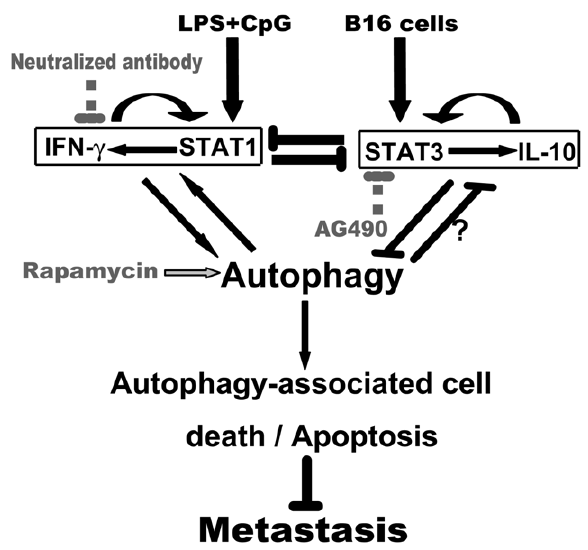
Figure 7. Mechanisms account for the different efficacies of prophylactic or therapeutic TLR4/9 agonist complex against metastasis. Prophylactic application of the TLR4/9 agonist complex results in the activation of IFN c /STAT1 signaling which stimulates autophagy and autophagy-associated tumor cell death. Neutralization of IFN c inhibits STAT1 and results in the attenuation of autophagy. Therapeutic application of the TLR4/9 agonist complex can not suppress metastasis because STAT3 is activated and expression of IL- 10 is enhanced by tumor cells, which reciprocally results in the suppression of IFN c /STAT1 signaling, autophagy, and subsequent tumor cell death. Inhibition of STAT3 activation by AG490 (or IL-10 antagonist) or activation of autophagy by rapamycin may suppress metastasis.